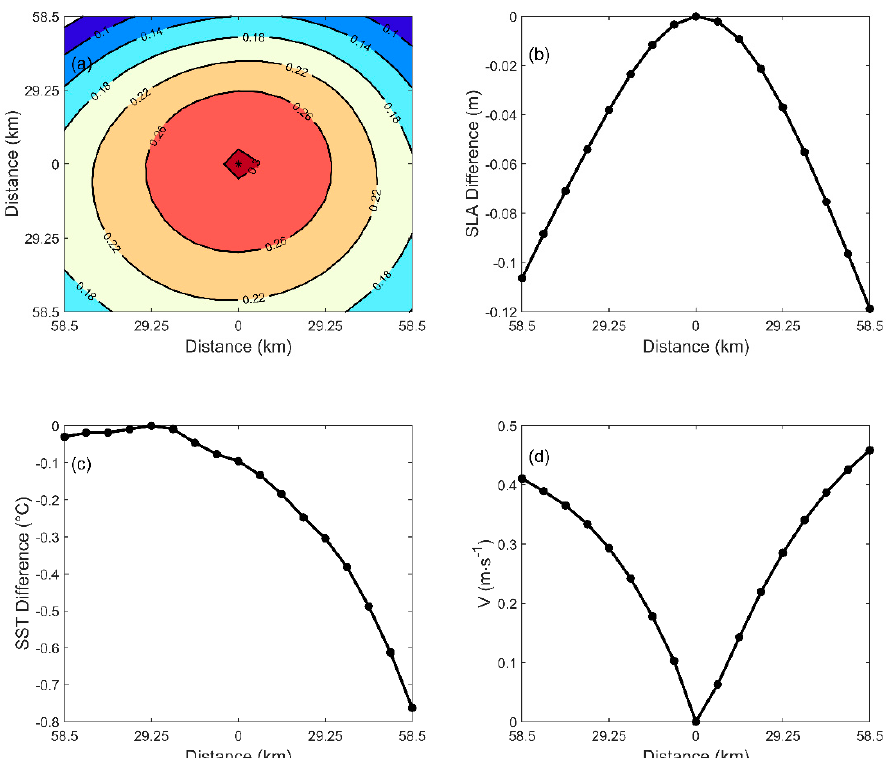
Figure 2. Schematic diagram of the composite of SLA ( a ), SLA difference ( b ), sea surface temperature (SST) difference ( c ) and meridional velocity ( d ) along the latitude of the GW center in July.